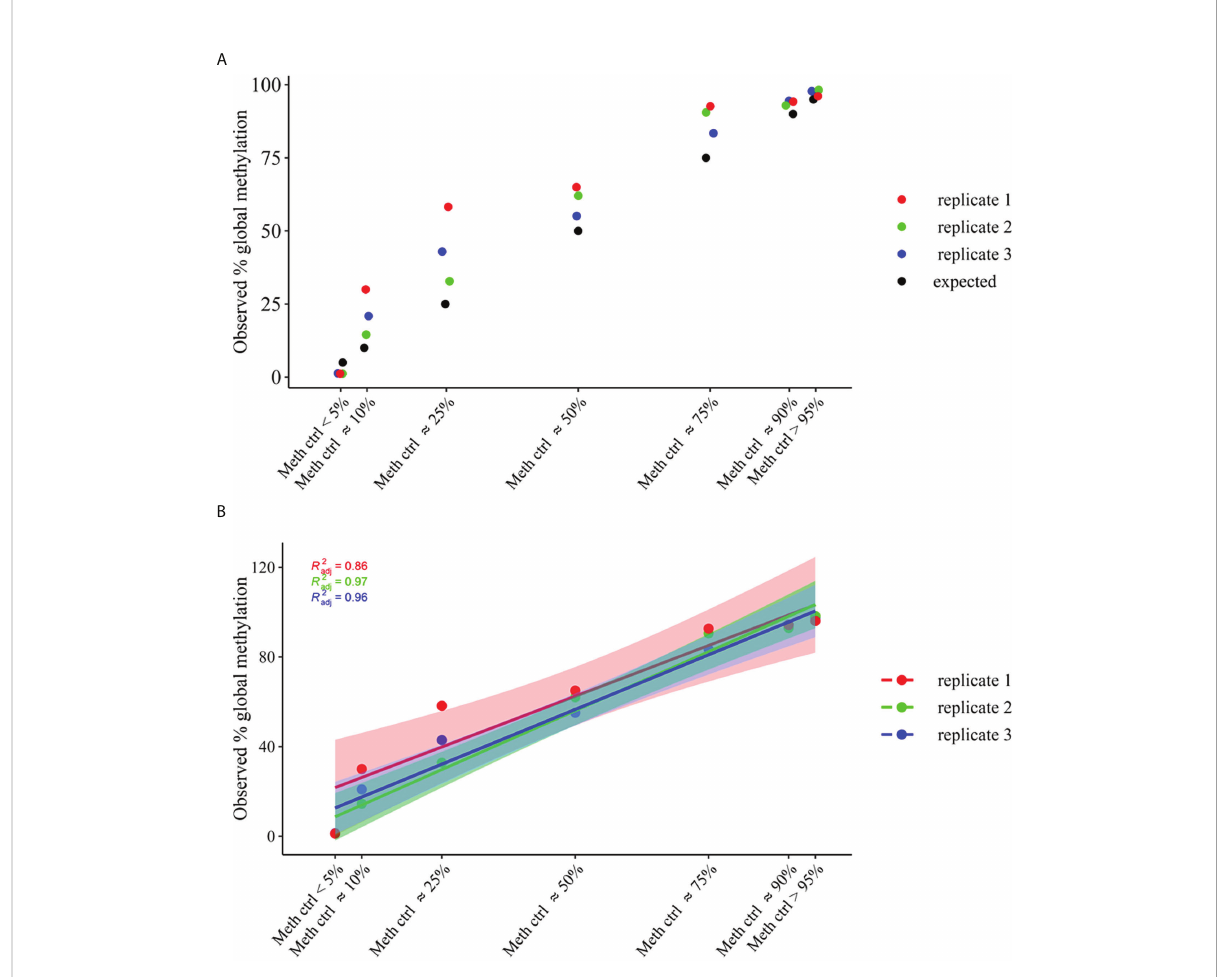
FIGURE 2 Global methylation levels across all amplicons (target_CpGs) of OPERA_MET-A panel. gDNA samples of average methylation states across all CpGs of approximately >95% and <5%, and different mixtures of methylation states (~90%, ~75%, ~50%, ~25% and ~10%) were used. (A) Distribution of observed global methylation levels for each gDNA control mixture in three replicates (replicate 1=red, replicate2=green, replicate3=blue), the expected ones are in black. (B) Linear regression analysis of global methylation levels for each gDNA control mixtures (replicate1=red, replicate2=green, replicate3=blue). The fi lled color areas represent the standard error of each